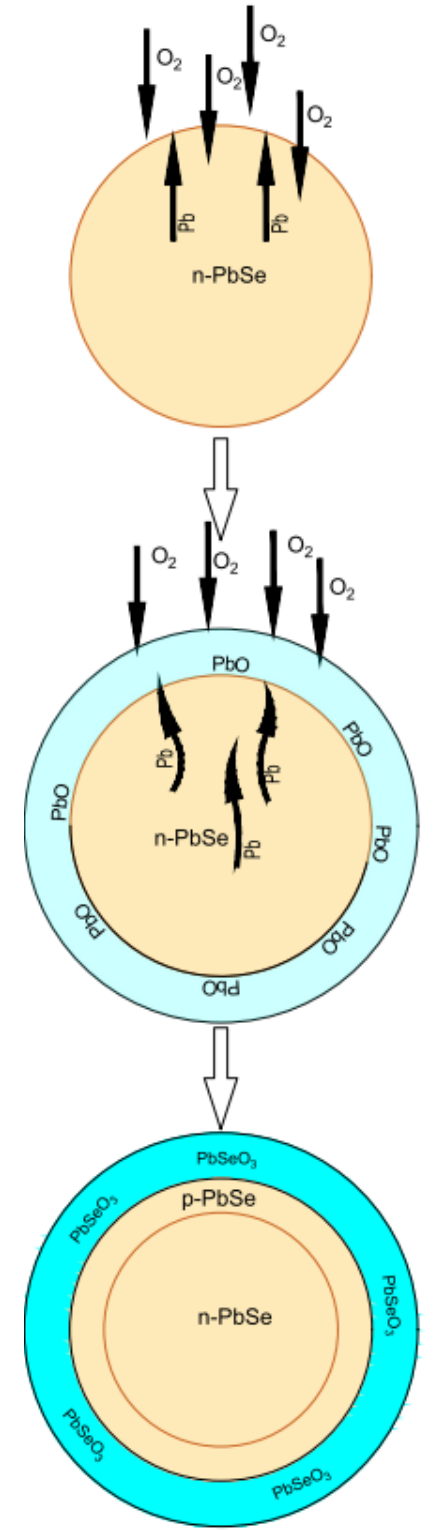
Figure 4. The oxidation process of the n-PbSe grain (schematically).